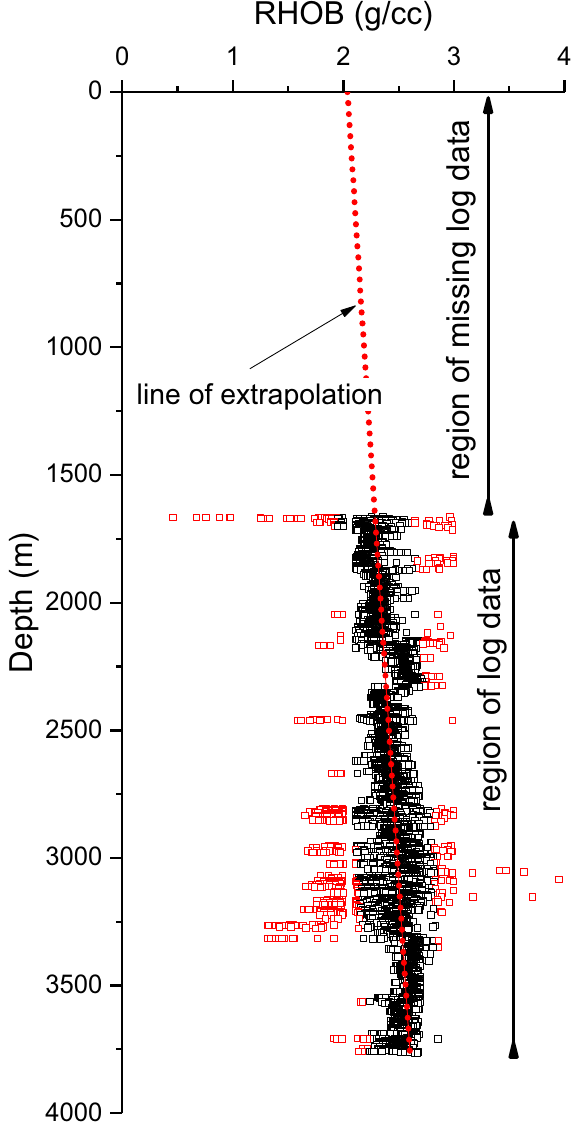
Figure 5. Missing RHOB data determination by extrapolation